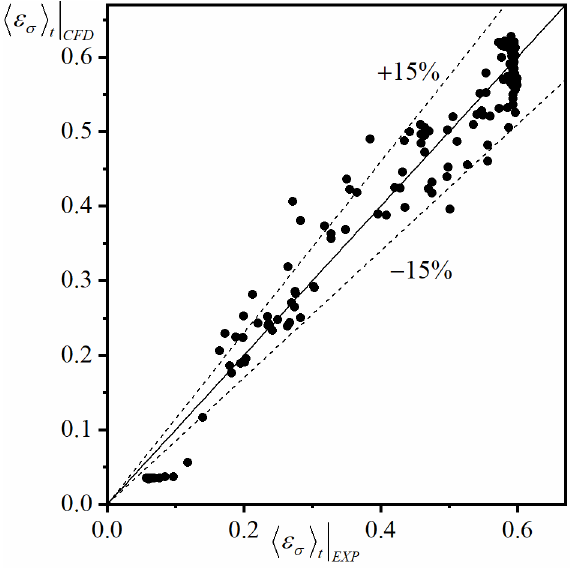
Figure 11. Parity plot of the experimentally measured and predicted pointwise solids holdup for all